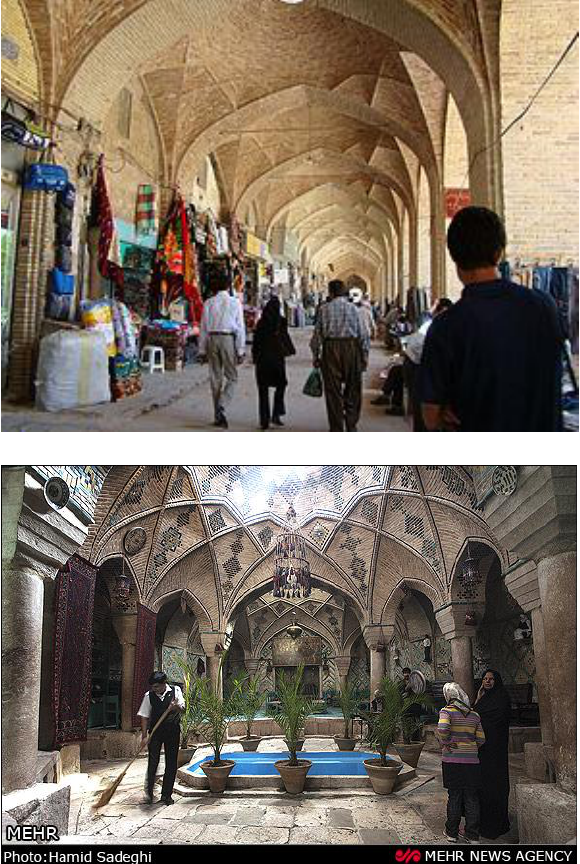
Figure 4-5. The main axis of Bazaar, including the shops and smaller sections